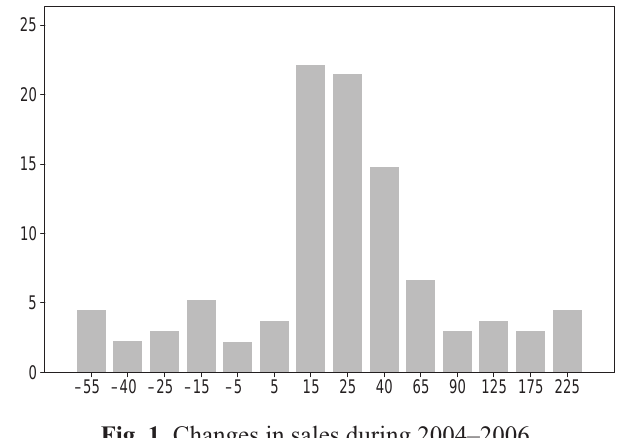
Fig. 1. Changes in sales during 2004–2006 in founder-run fi Table 1. Comparative analysis of factors